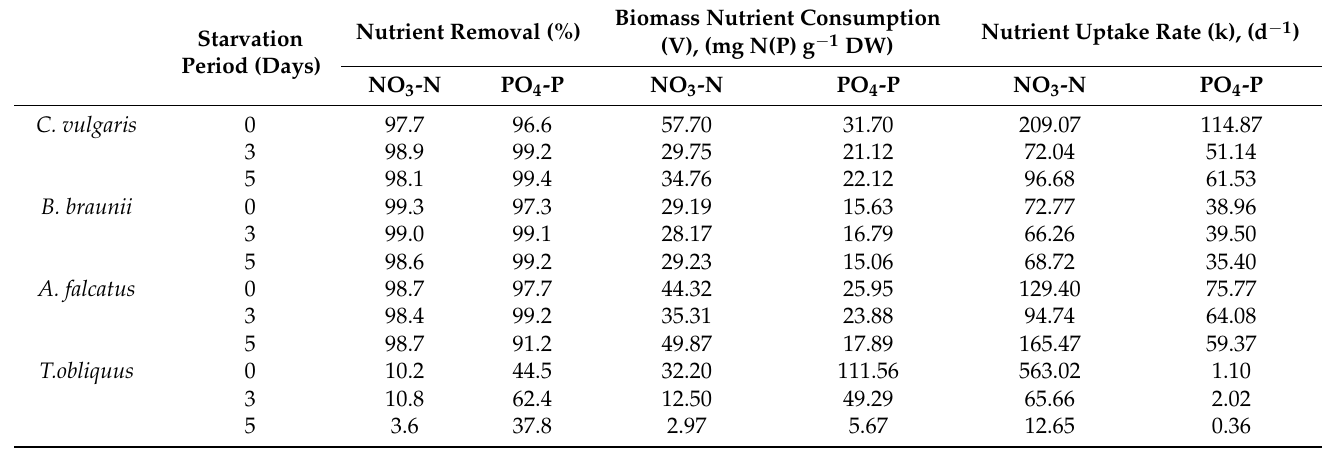
Table 3. Nutrient removal rates and biomass uptake kinetics (mean values, n = 3). Starvation